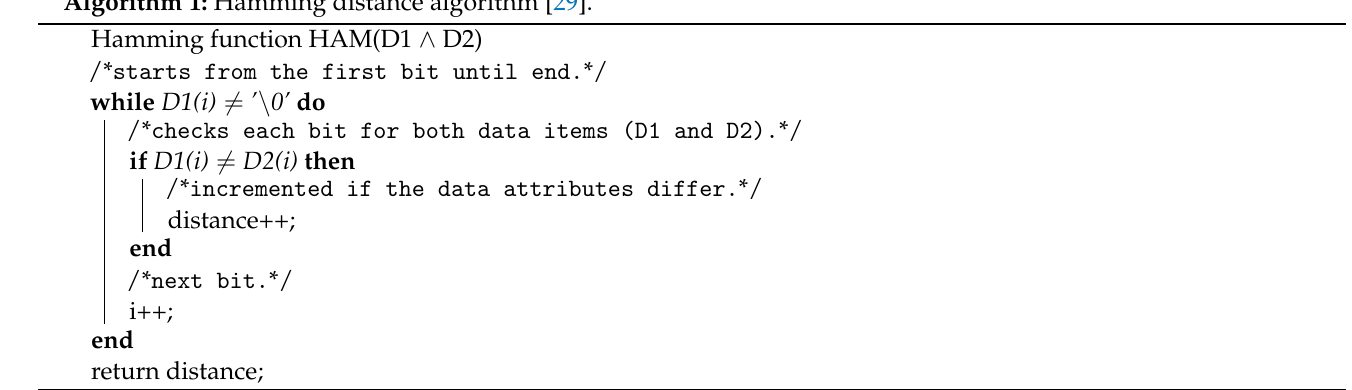
Algorithm 1: Hamming distance algorithm